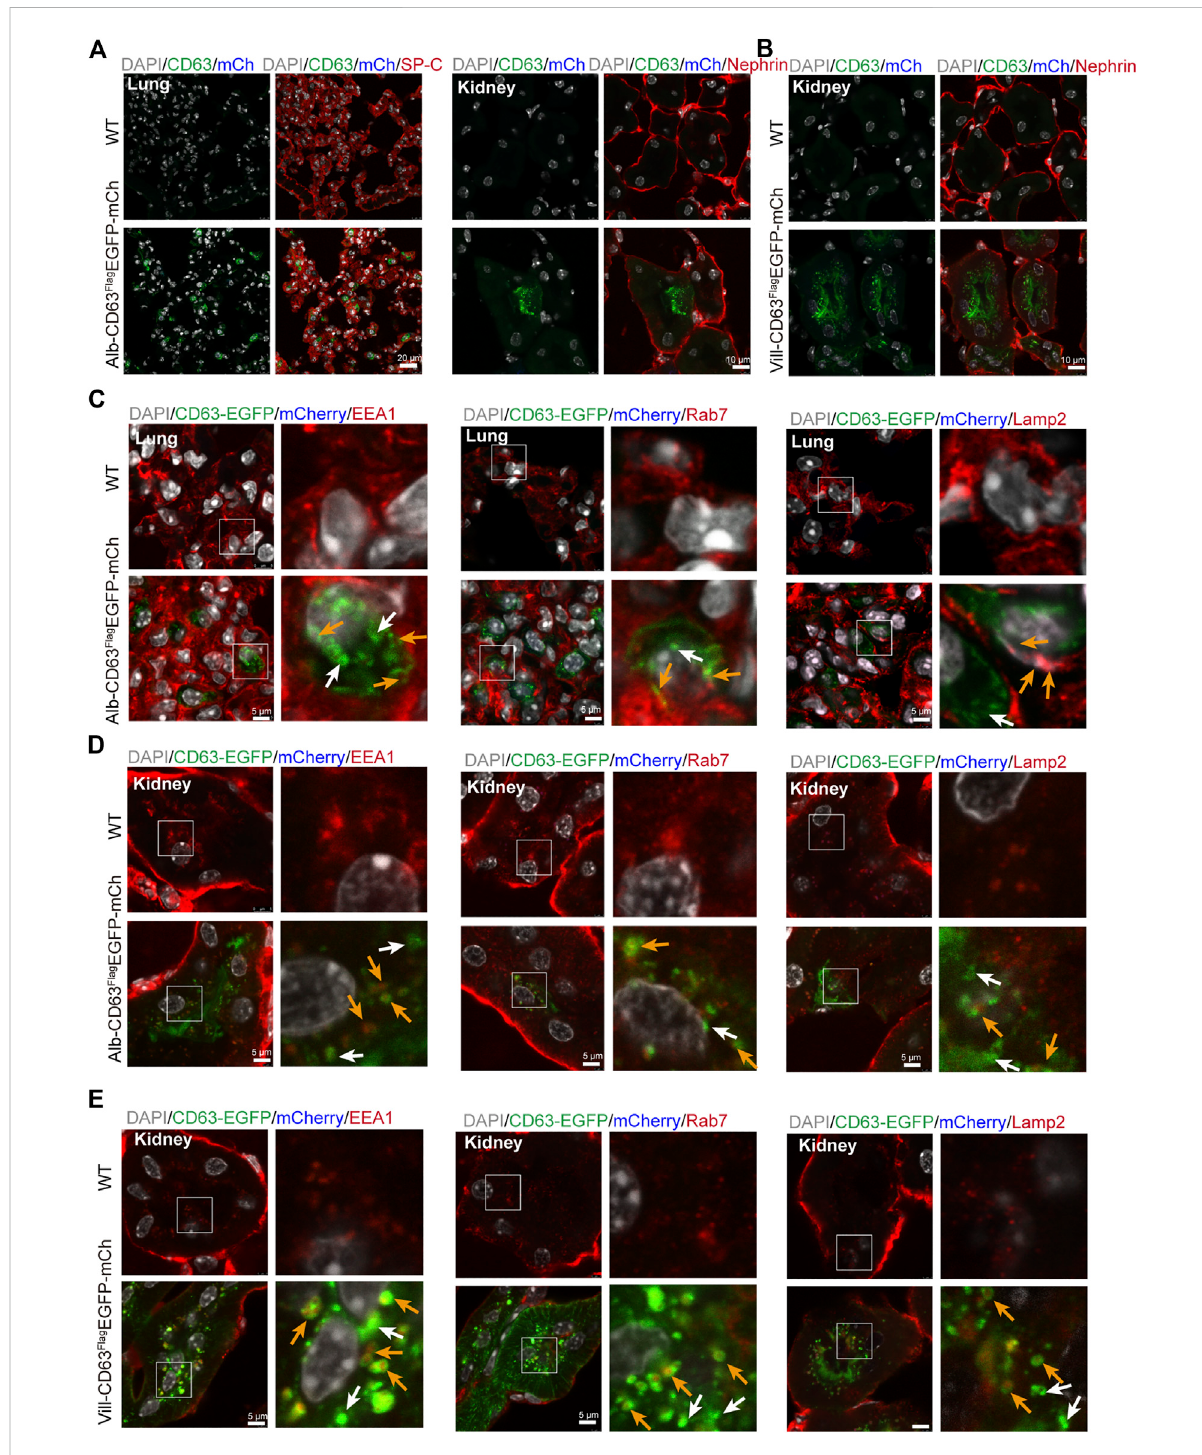
FIGURE 4 The distal organs cell type and organelles taking up EVs. (A) Immunostained alveolar cell (SP-C, left) and podocyte cell (Nephrin, right) colocalizationwithEGFPandmCherry fl uorescentinthealb-CD63 Flag EGFP-mCherrymouse.Grey,Nucleus;Green,GFP;Blue,mCherry;Red,SP-C/ Nephrin. (B) Immunostainedpodocyte cell(Nephrin)colocalizationwithEGFPandmCherry fl uorescentinthevillin-CD63 Flag EGFP-mCherry mouse. Grey, Nucleus; Green, GFP; Blue, mCherry; Red, Nephrin. (C,D) Immunostained organelles of lung and kidney (early endosome, EEA1; MVB, Rab7; lysosome, Lamp2) colocalization with EGFP and mCherry fl uorescent in the alb-CD63 Flag EGFP-mCherry mouse. Grey, Nucleus; Green, GFP; Blue, mCherry; Red, Rab7/Lamp2/EEA1 (Scales bar, 5 um). (E) Immunostained organelles of kidney (MVB, Rab7; lysosome, Lamp2; early endosome, EEA1) colocalization with EGFP and mCherry fl uorescent in the villin-CD63 Flag EGFP-mCherry mouse. Grey, Nucleus; Green, GFP; Blue, mCherry; Red, Rab7/Lamp2/EEA1 (Scales bar, 5